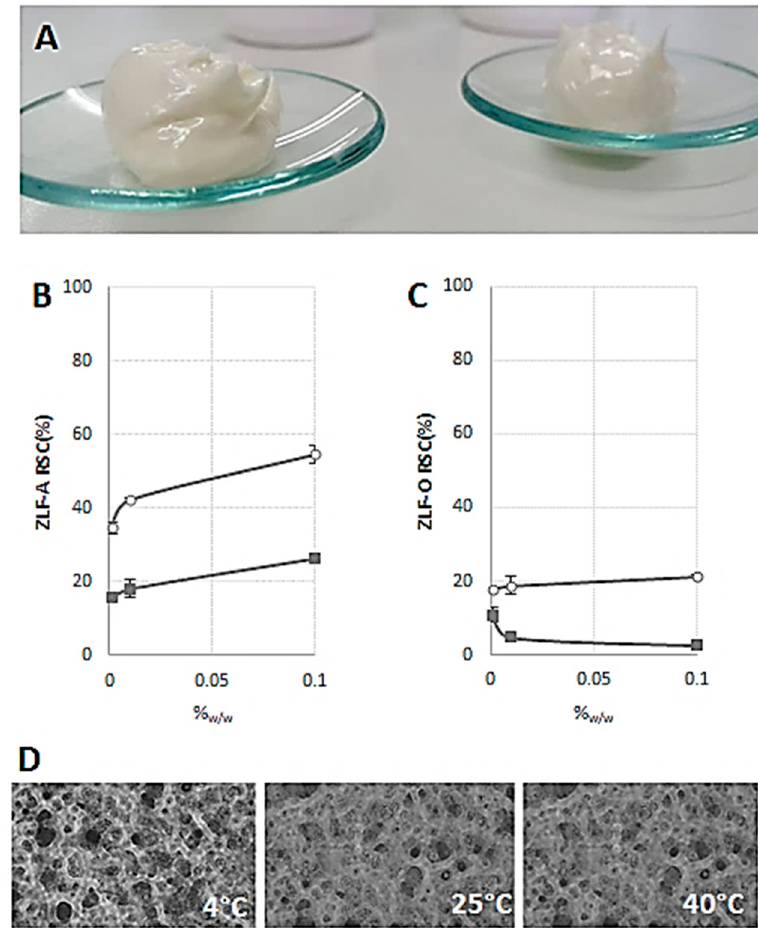
Figure 4. ZLF-A enriched emulsion ( A ); Radical Scavenging Capacity (RSC, %) of ZLF-A enriched emulsion ( B ) and ZLF-O enriched emulsion ( C ) towards DPPH radical ( ■ ) and ABTS radical cation ( ○ ). Values, reported as percentage vs. a blank, are the mean ± SD. Representative microscopy images of ZLF-A enriched emulsion stored at 4 °C, 25 °C and 40 °C ( D ). Images were acquired by Nikon Eclipse TE300 microscope.